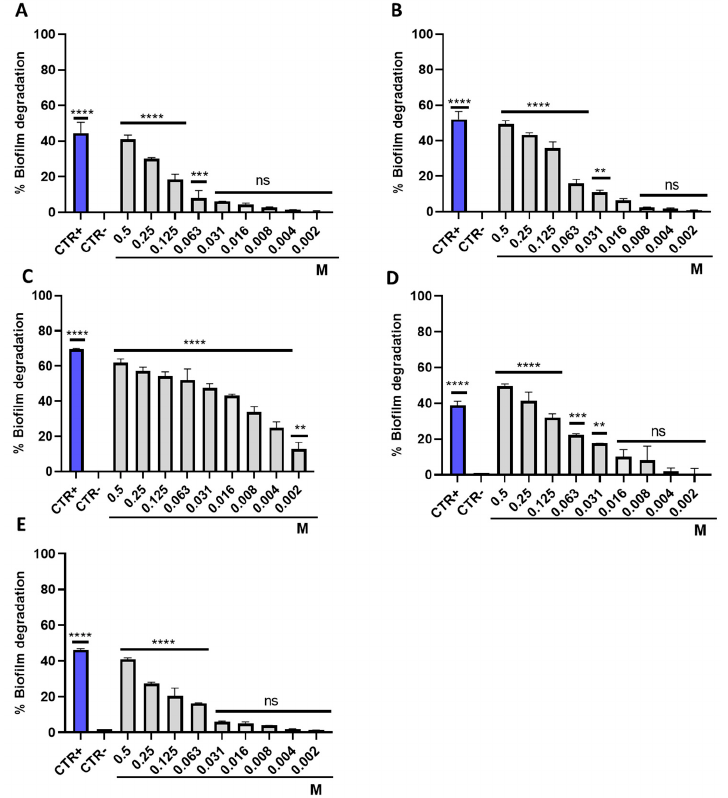
Figure 4. Anti-biofilm activity of IDSK on: ( A ) Escherichia coli , **** p < 0.0001, *** p = 0.0001, ns non- significant; ( B ) Staphylococcus aureus , **** p < 0.0001, ** p = 0.0018, ns non-significant; ( C ) Salmonella enterica , **** p < 0.0001, ** p = 0.0027; ( D ) Enterococcus faecalis , **** p < 0.0001, *** p = 0.0004, ** p = 0.0023, ns non-significant; ( E ) Pseudomonas aeruginosa , **** p < 0.0001, ns non-significant.